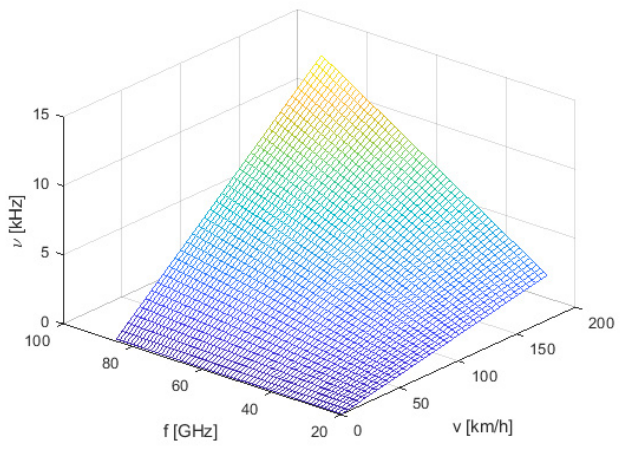
Figure 7. Maximum Doppler shift produced at different carrier frequencies and relative speeds between Tx and Rx.